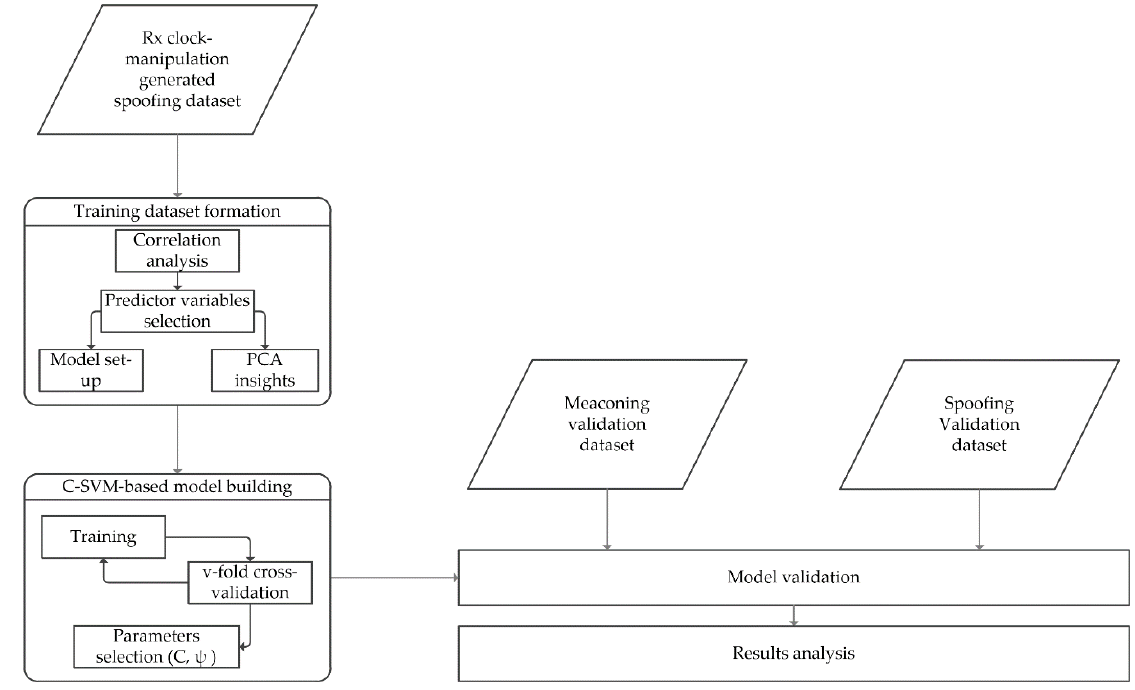
Figure 2. Process flow of Experiments I and II.